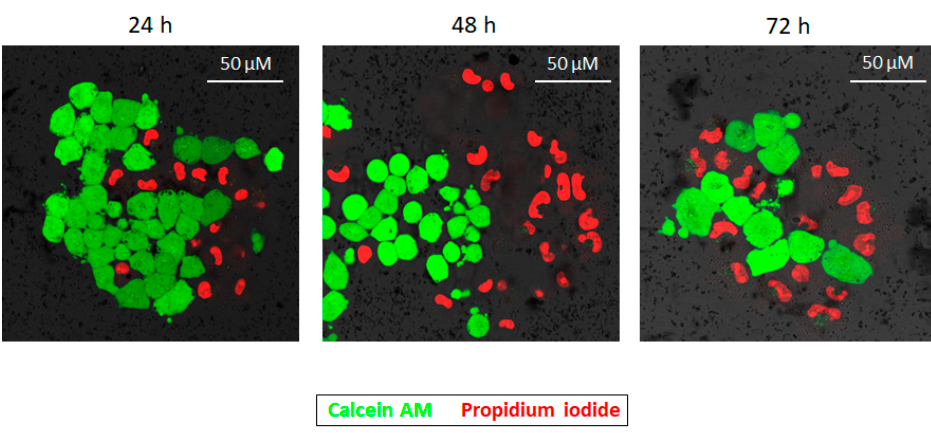
Figure 4. CMLS images taken 24, 48 and 72 h after the treatment of BT474 cells with 115 nm PD NPs (0.042 mg/mL). Calcein AM (in green, excited at 495 nm, indicator of cellular viability) and PI (in red, excited at 493 nm, indicator of cellular death) were selected to be performed in an alive/dead assay.